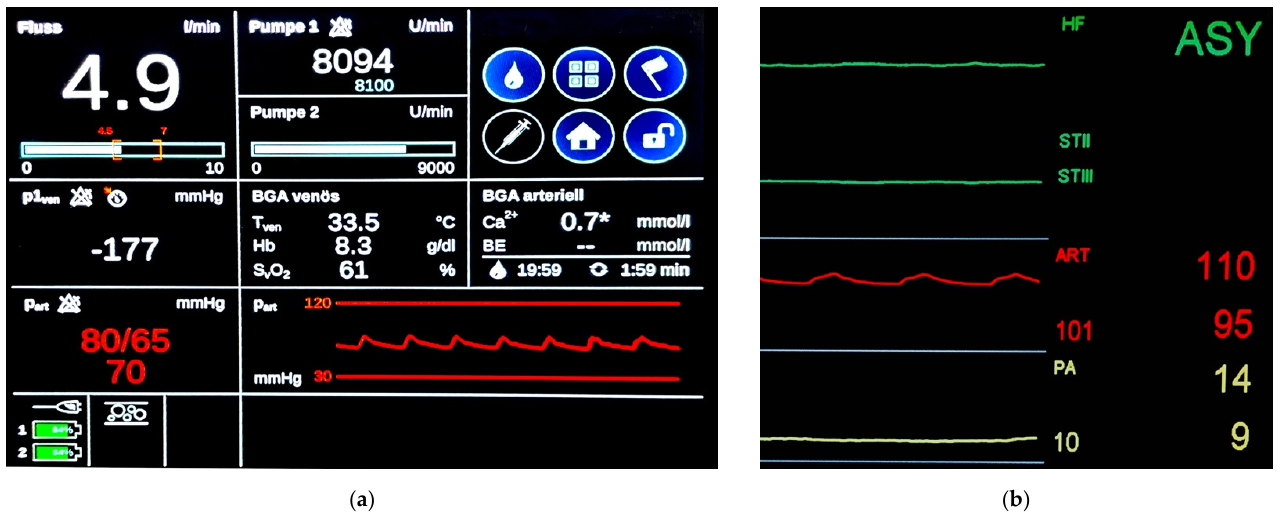
Figure 2. Pulsatile blood flow on ECC during CARL therapy: ( a ) Screenshot from real-time measurements on the CARL controller during asystole reperfusion. A pulsatile blood pressure was observed during extracorporeal circulation in the ascending aorta during asystole phase (red curve); ( b ) Screenshot of experimental monitoring during ECC. Despite asystole (green curve), a pulsatile blood flow (red curve) is detected in the common carotid. Pulmonary artery (PA) pressure is displayed in yellow.